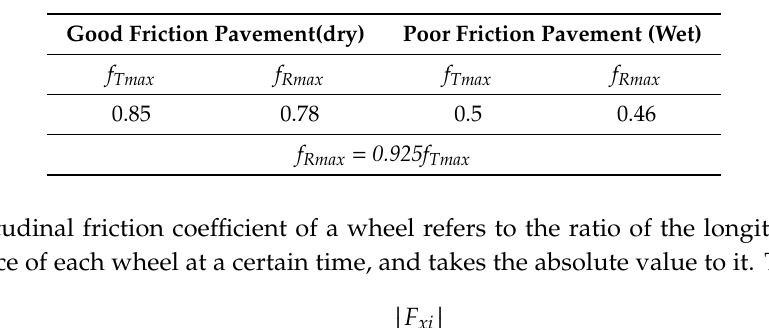
Table 3. Good friction and poor friction values.